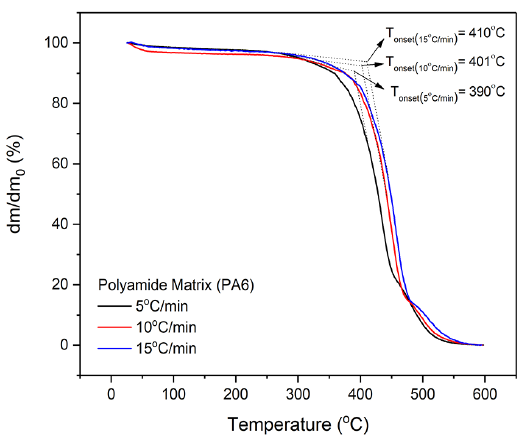
Figure 2. TGA weight results for the 10mg PA matrix samples under three different heating rates. (Bibliographic Source: Author.)